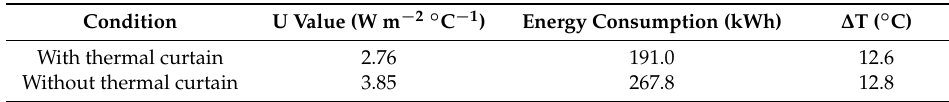
Table 1. Comparison of U values and energy consumption of the greenhouses with and without thermal curtains.